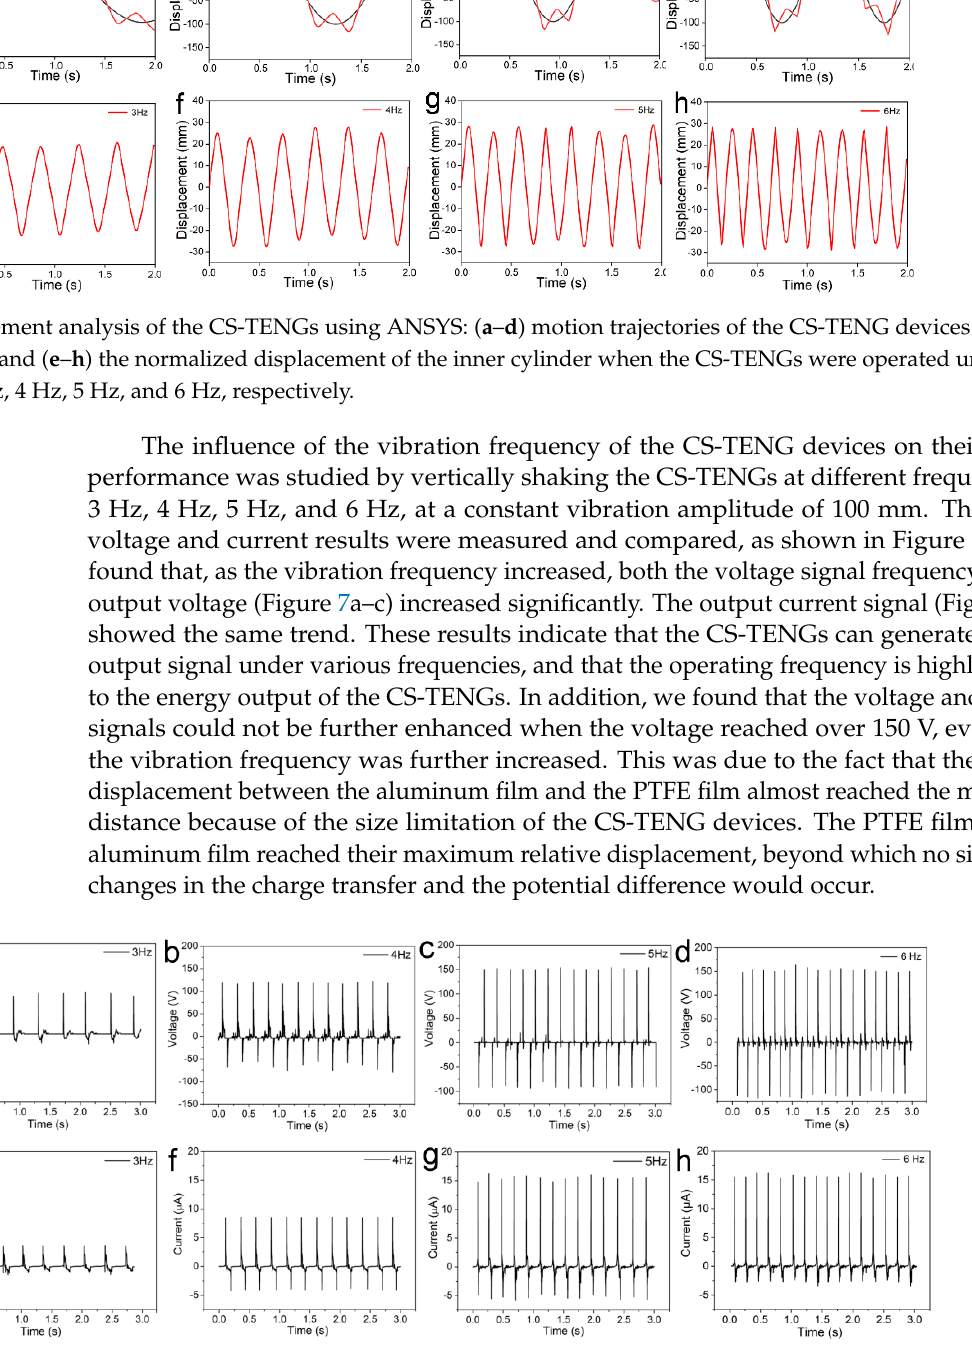
Figure 7. ( a – d ) Output voltage results for CS-TENGs when operated vertically at a vibration frequency of 3–6 Hz. ( e – h ) Output current results for CS-TENGs when operated vertically at a vibration frequency of 3–6 Hz.